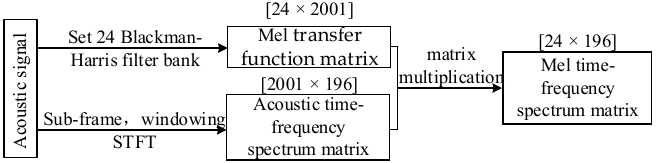
Figure 8. Calculation process of Mel spectrum.